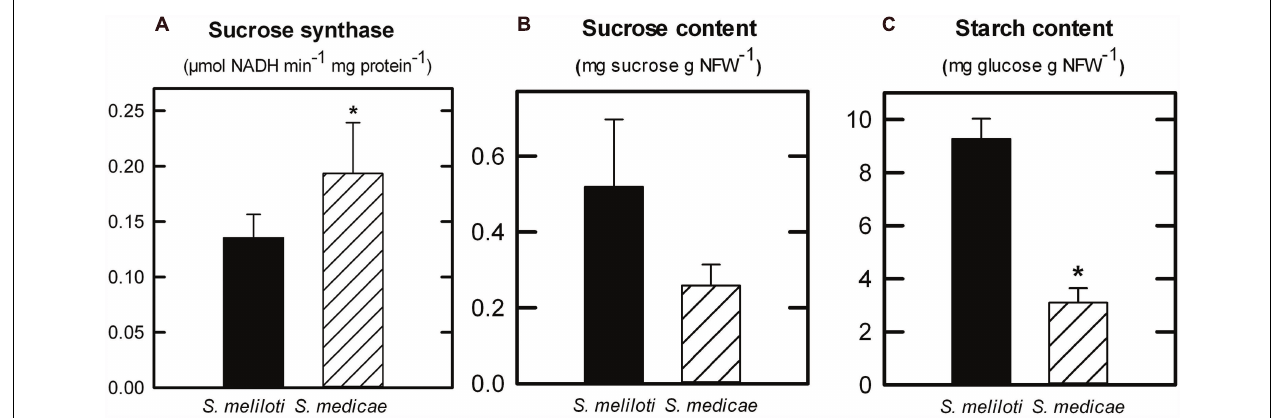
FIGURE 4 | Sucrose synthase (A) enzymatic activity in M. truncatula nodules inoculated with either S. meliloti 2011 or S. medicae WSM419. Values are given in μ mol NADH min − 1 mg plant protein − 1 and represent mean ± standard deviation ( n = 5). Sucrose (B) and starch content (C) in M.